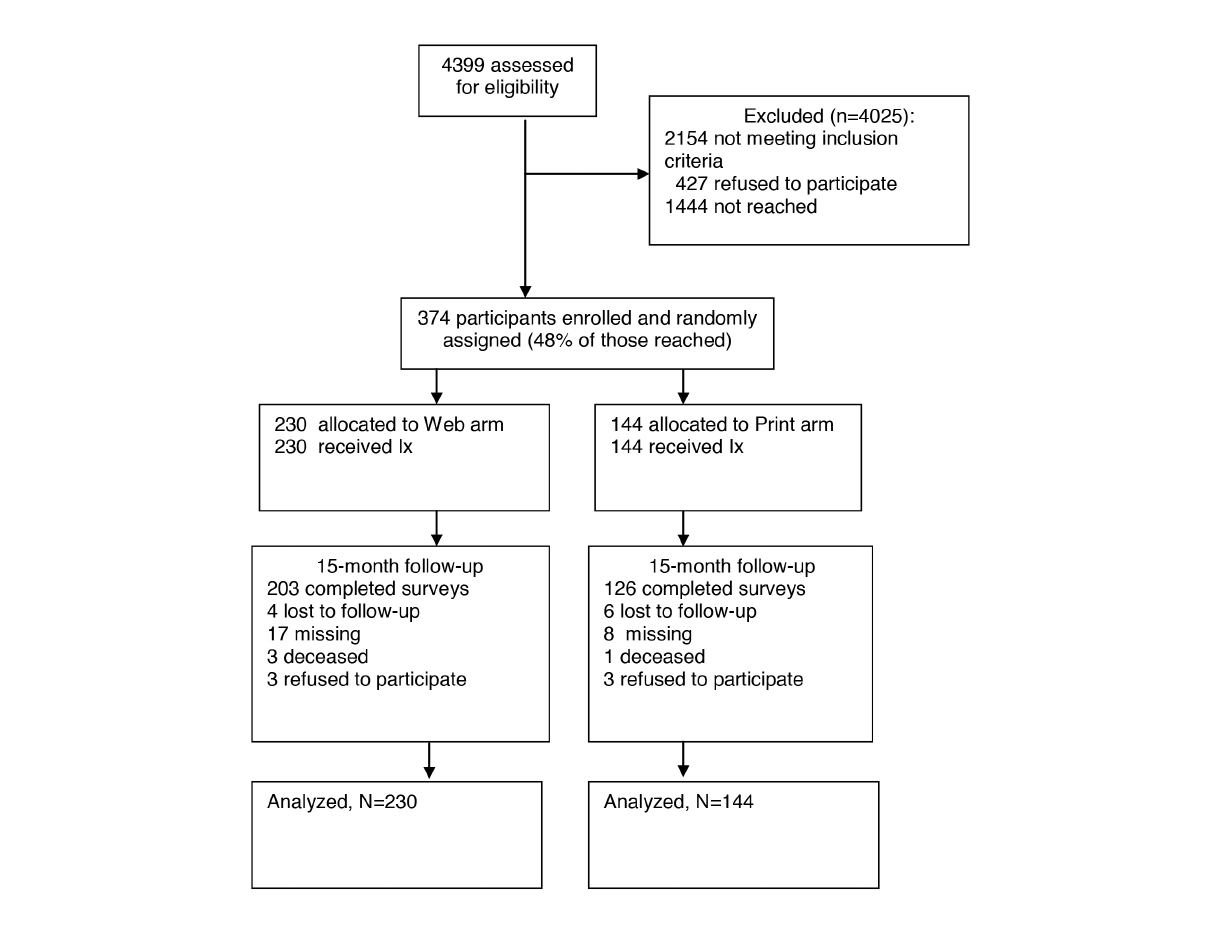
Figure 2. Recruitment and retention rates (Consolidated Standard of Reporting Trials Statement -